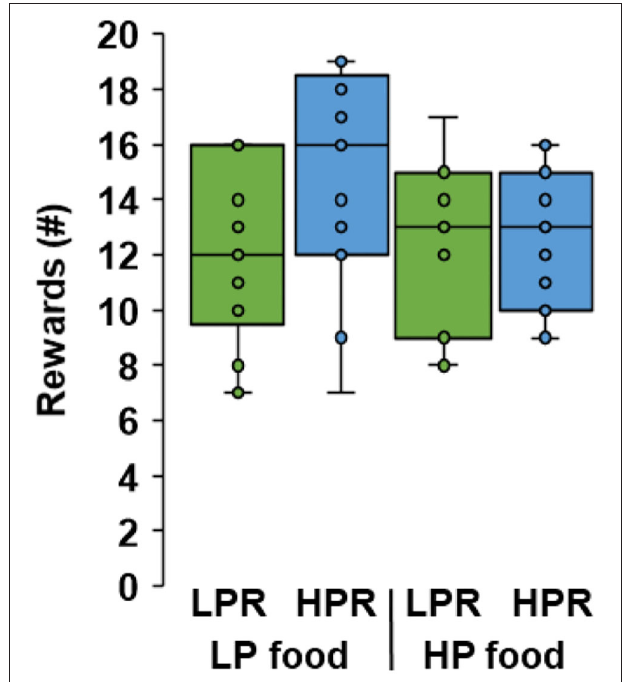
FIGURE 2 | Boxplots for number of rewards obtained by lever pressing for kibbles with low (LPR) or high (HPR) protein content. Cats ( n = 5) were adapted to wet foods with a low protein (LP) or a high protein (HP) content and tested for motivation around 5h after their morning meal. Similar numbers of HP and LP rewards were obtained irrespective of food provided ( P = 0.550 for food × reward). Boxes show the interquartile ranges and whiskers show the minimum and maximum